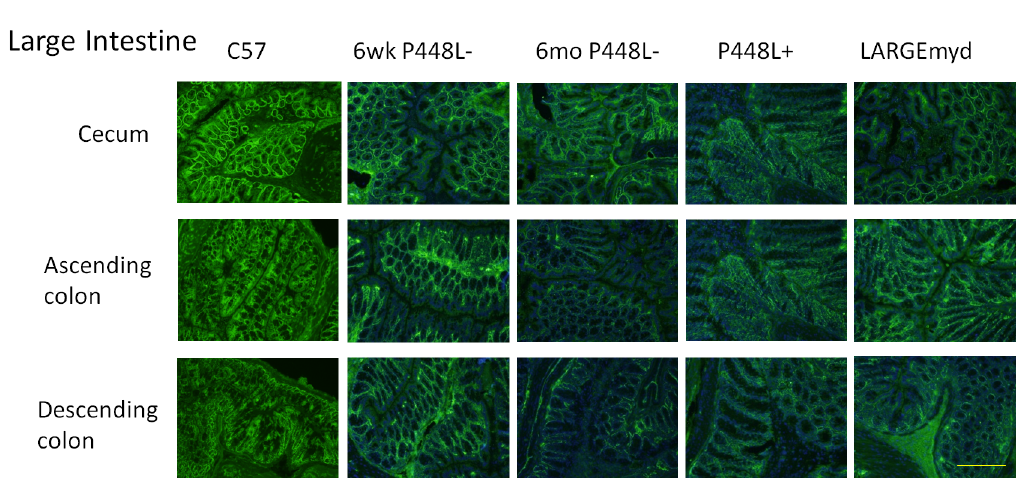
Fig 9. Expression of F- α -DGin regions of large intestine. Strong expression is demonstrated in the epithelial cells in P448Lneo- mutant mouse with patchy expression in the P448Lneo+ and LARGE myd mouse.